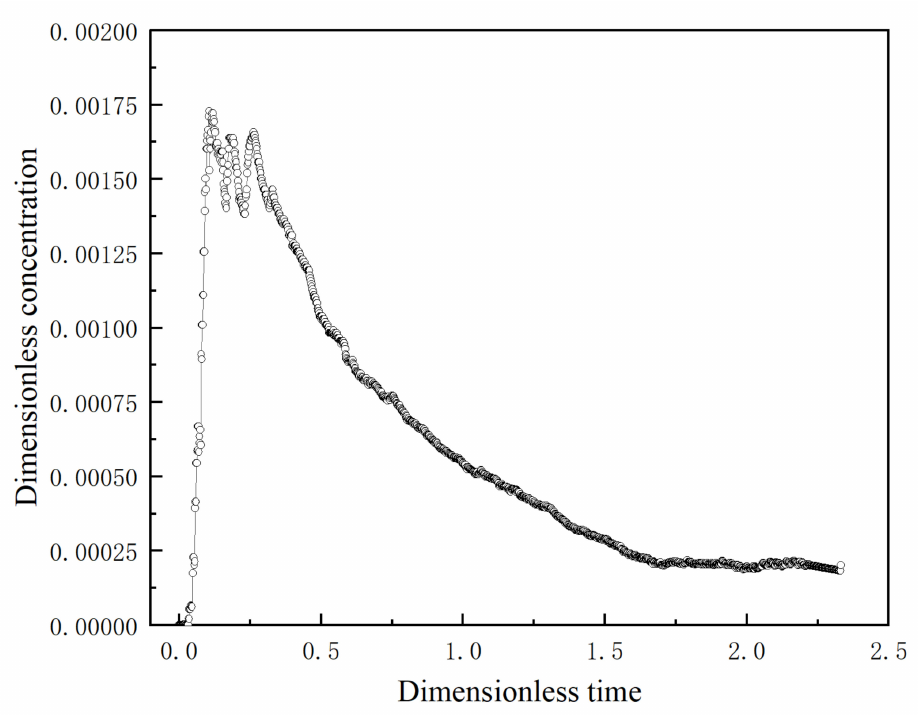
Figure 6. Characteristic RTD